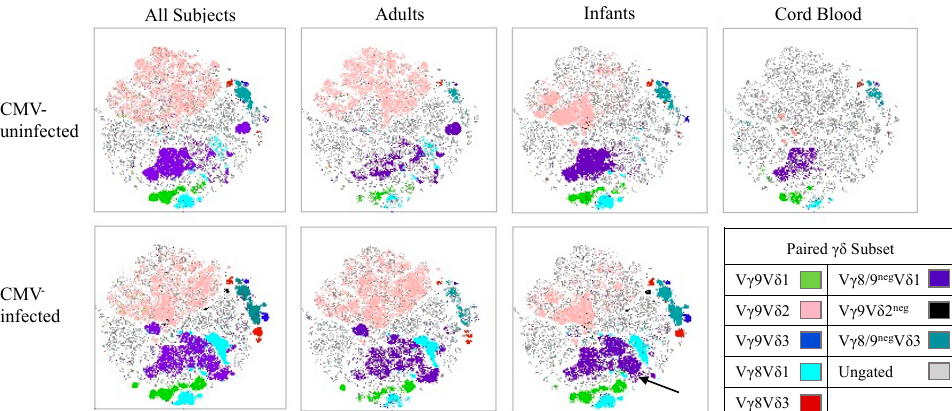
Figure 6. t-SNE clustering reveals specific γδ T cell populations associated with CMV infection. ( A ) Gating strategy for paired γδ T cells using spectral flow cytometry. Initial flowCut cleaning was followed by singlet, lymphocyte, CD3 + and total γδ T cell gates. Next paired subsets were gated as shown; ( B ) Canadian and Ugandan adults ( n = 21), Ugandan infants ( n = 15) and Canadian cord ( n = 3) PBMC samples were stained, and data collected via spectral flow cytometry. Unsupervised t-SNE clusters were generated from a concatenated file of live γδ T cells from all subjects and then overlaid with manually gated paired γδ subsets. A CMV-associated CD57 + NKG2C + cluster within V γ 8 neg /9 neg V δ 1 cells in infants is indicated by the black arrow.